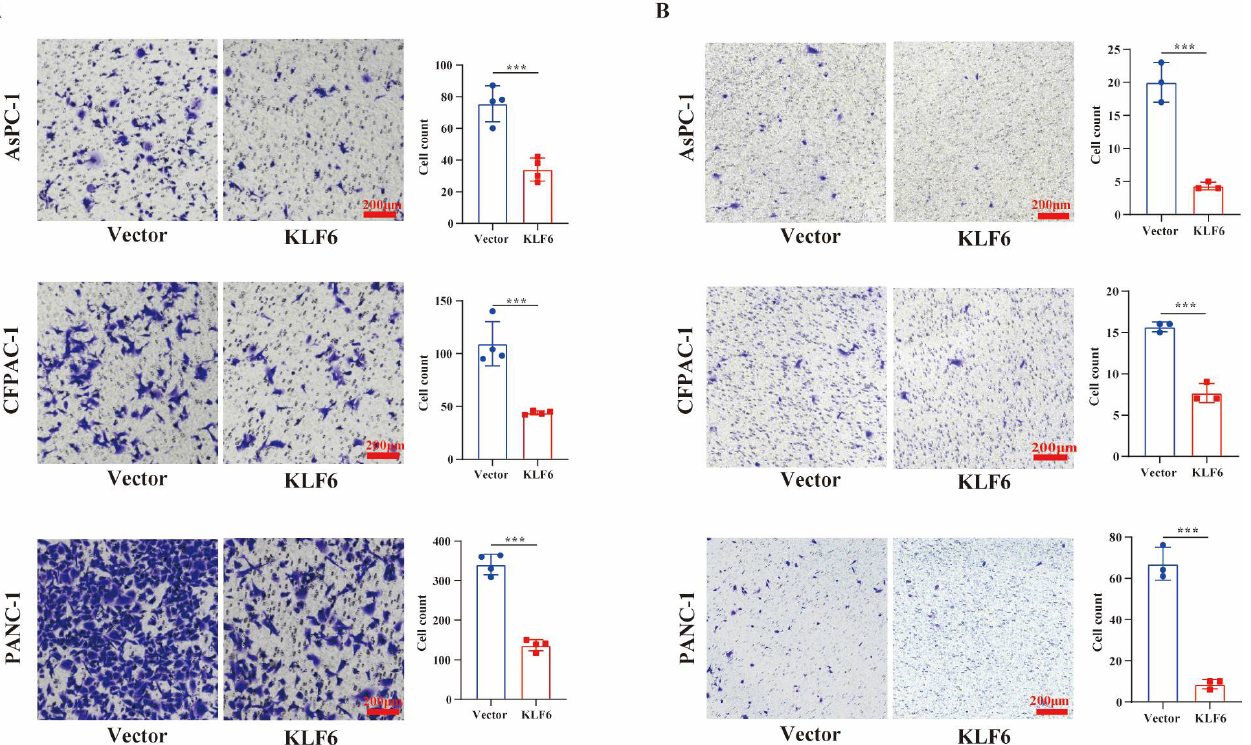
Figure 3. Overexpression of KLF6 inhibits metastasis of pancreatic cancer cells. ( A ) Cell migration ability of AsPc-1, CFPAC-1, and PANC-1 cells after KLF6 overexpression, respectively. Data represent mean ± SD; n = 4. *** p < 0.001. ( B ) Cell invasion ability of AsPc-1, CFPAC-1, and PANC-1 cells after KLF6 overexpression, respectively. Data represent mean ± SD; n = 3. *** p < 0.001.